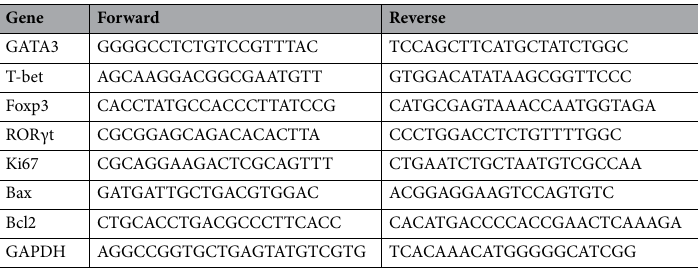
Table 5. The list of the primers’